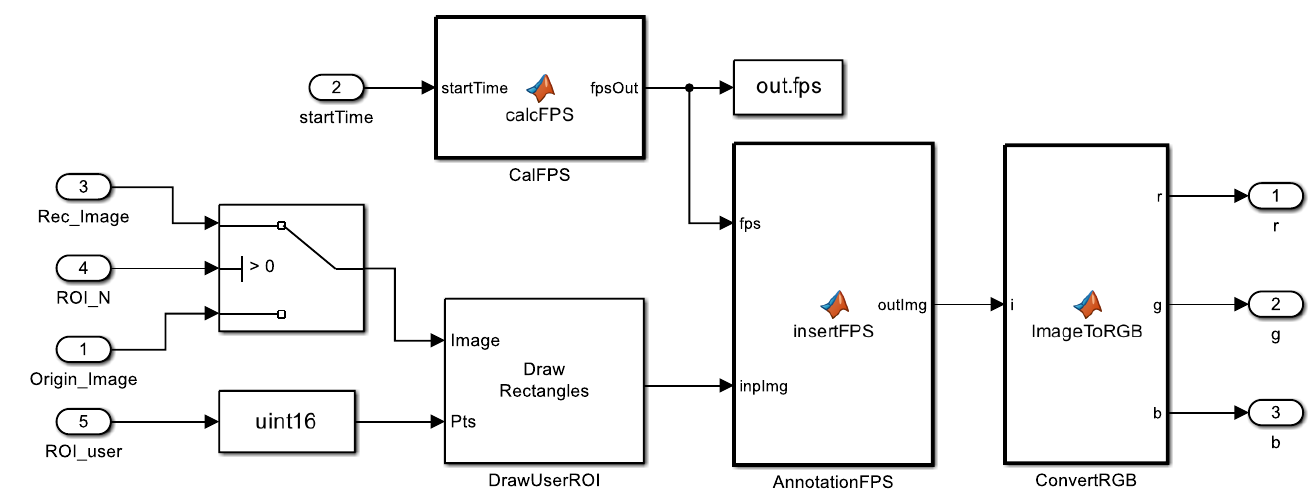
Figure 5. Digit annotation block in